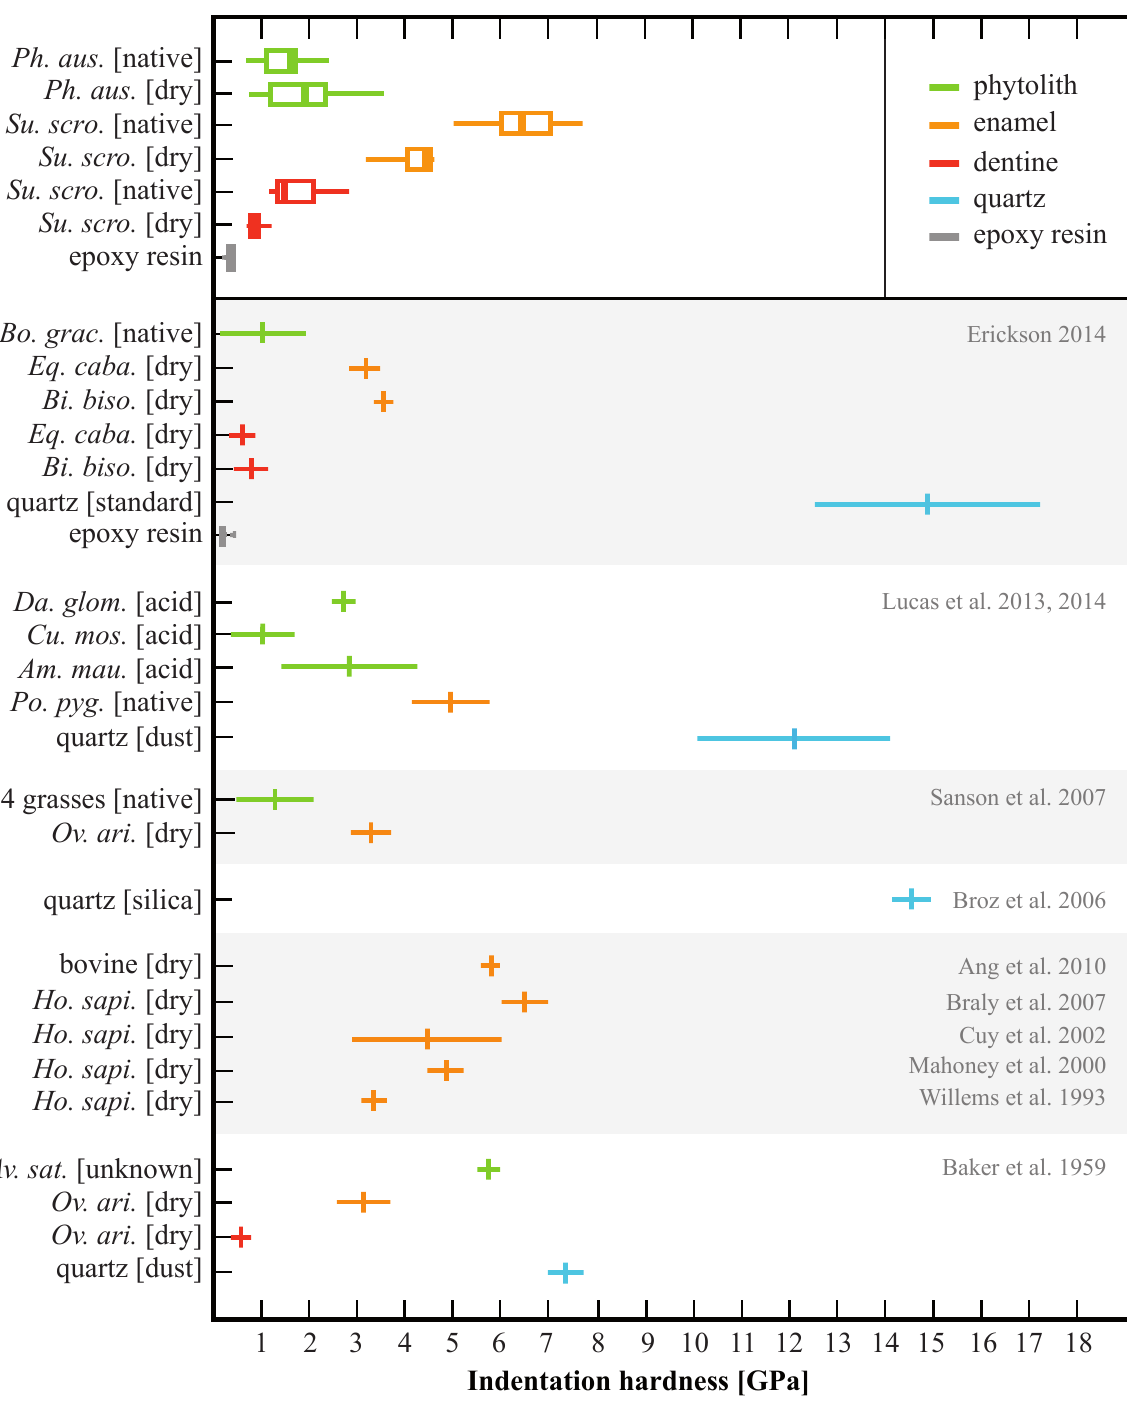
Figure 2. Indentation hardness of phytoliths, dental tissues, environmental dust and quartz particles. Upper section: nano-indenta- tion data presented here, band inside the box plots = median, box = 1Q = first quartile, 3QR = third quartile, end of the whiskers = minimum and maximum values; epoxy resin values used for embedding given as comparative. Lower section: published compara- tive data by Ang et al. (2010), Baker et al. (1959), Broz et al. (2006), Cuy et al. (2002), Erickson (2014), Lucas et al. (2013), Lucas et al. (2014), Mahoney et al. (2000), Sanson et al. (2007), Willems et al. (1993) converted following Chudoba and Griepentrog (2005), only mean, and minimum to maximum values were available; plant phytoliths: Am. mau. = Ampelodesmos mauritanicus , Av. sat. = Avena sativa, Bo. grac . = Bouteloua gracilis , Cu. mos. = Cucurbita moschata, Da. glom =Dactylis glomerata, Ph. aus. = Phragmites australis ; dental tissues: Bi. biso. = Bison bison, Eq. caba . = Equus caballus , Ho. sapi. = Homo sapiens , Ov. ari. = Ovis aries, Po. pyg. = Pongo pygmaeus , Su. scro. = Sus scrofa